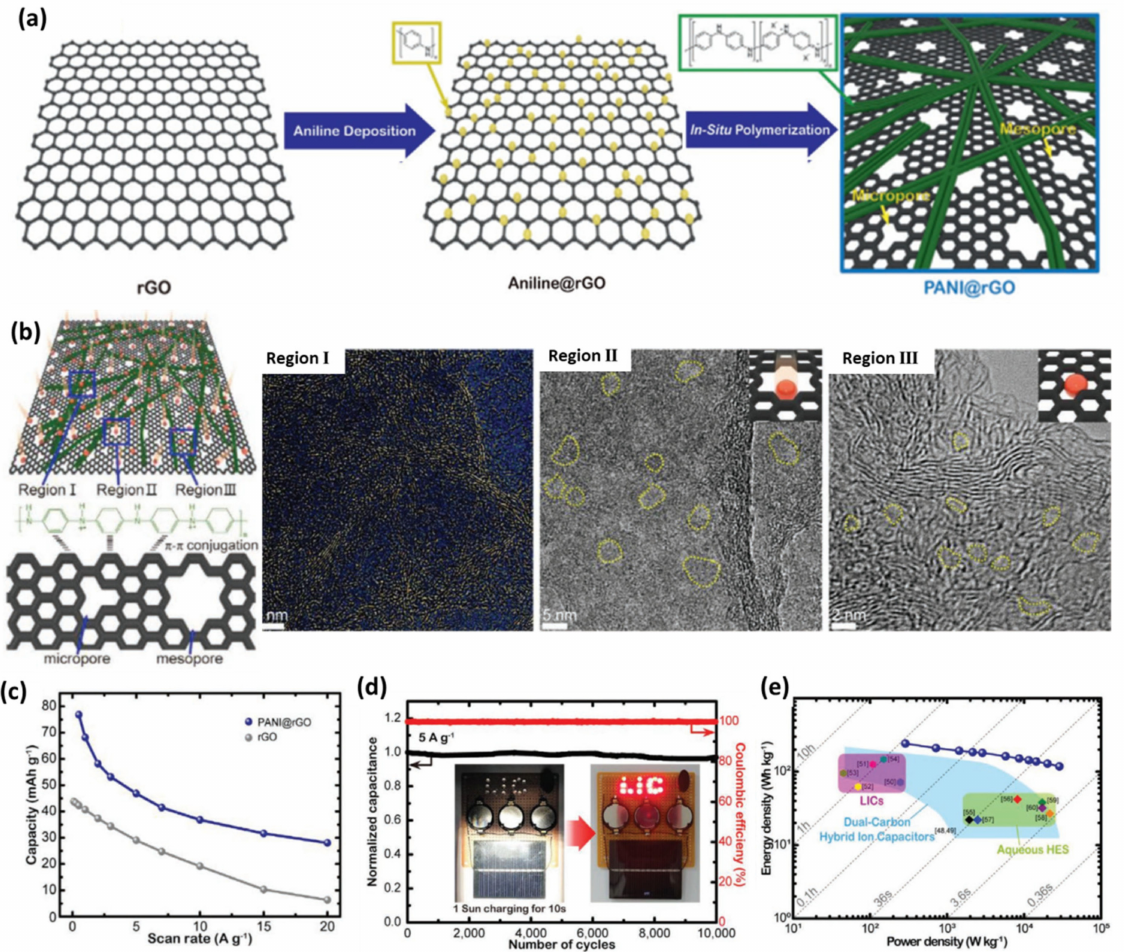
Figure 11. ( a ) Schematic illustration of in situ polymerized polyaniline chain web cathode units integrated into rGO sheets to form the PANI@rGO cathode; ( b ) Schematic images of ion storing of PANI@rGO cathode and π – π conjugation between the PANI chain and rGO sheet and HRTEM images of region I (conjugated PANI, temperature mode), region II (mesopores), region III (micropores); ( c ) Rate capabilities of PANI@rGO and rGO; ( d ) Cycling stability and ( e ) Ragone plot of MoO 2 @rGO//PANI@rGO LICs. (Reprinted with permission from Ref. [128]. Copyright 2020